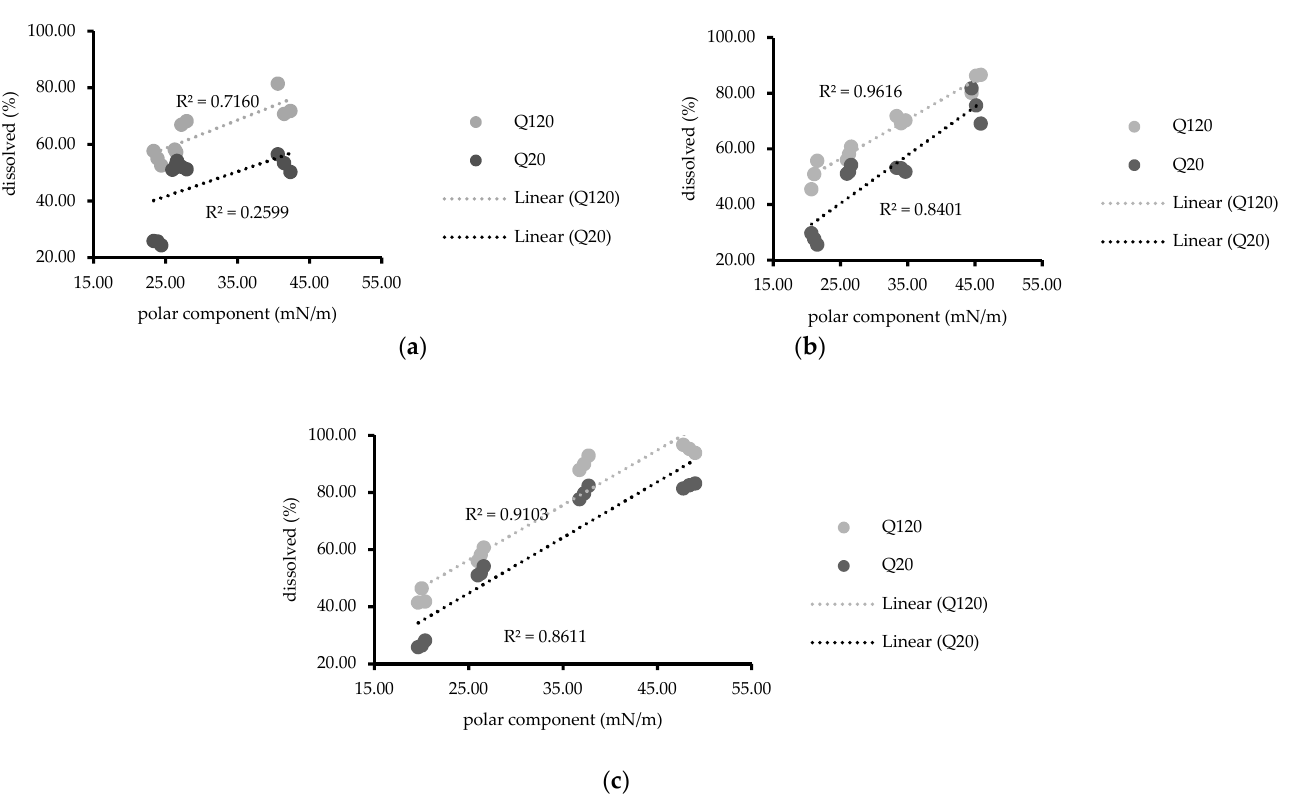
Figure 7. Relationship between the polar component and percentages of drug dissolved (20 and 120 min) at polysorbate concentrations of ( a ) 0.1%, ( b ) 0.3%, and ( c ) 0.6%.